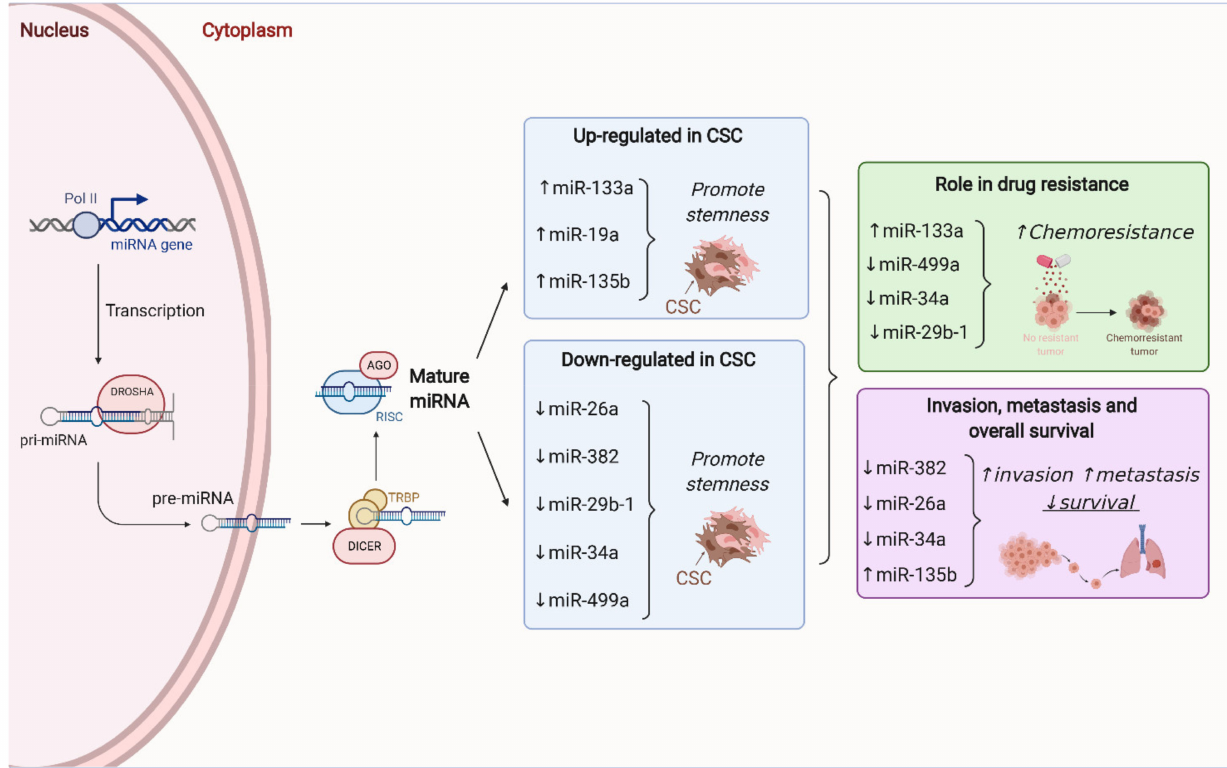
Figure 2. Role miRNAs in stemness and drug resistance in bone sarcomas. MicroRNAs (miRNAs) are regulatory RNA molecules that can simultaneously modulate the expression of a panel of target genes and thus control different cell phenotypes. The process of miRNA transcription and maturation and the enzymes involved in the different steps are shown in the left part of the figure. Right-hand side panels show relevant miRNAs whose upregulation ( ↑ ) or downregulation ( ↓ ) has been associated with stemness, chemoresistance, metastatic dissemination and/or lower patient survival in bone